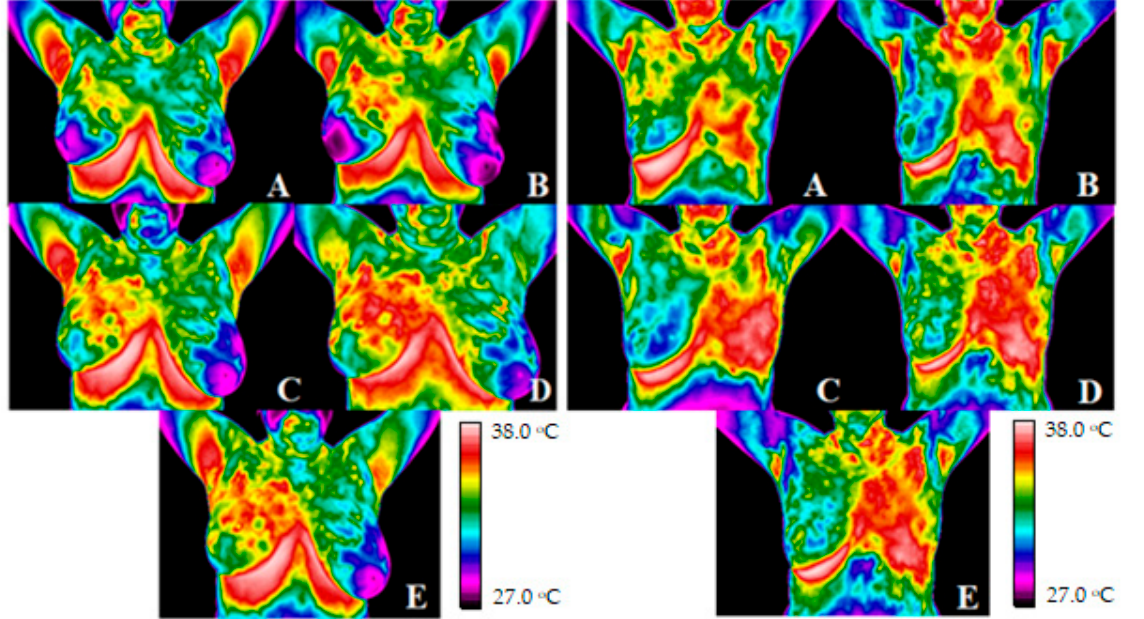
Figure 2. Thermograms of an exemplary patient after conserving surgery ( left ) and mastectomy ( right ) taken before radiotherapy (thermogram A ), after the first week of treatment (thermal image B ), after the second week of treatment (thermal image C ), after the third week of treatment (thermal image D ), and after the fourth week of treatment (thermal image E